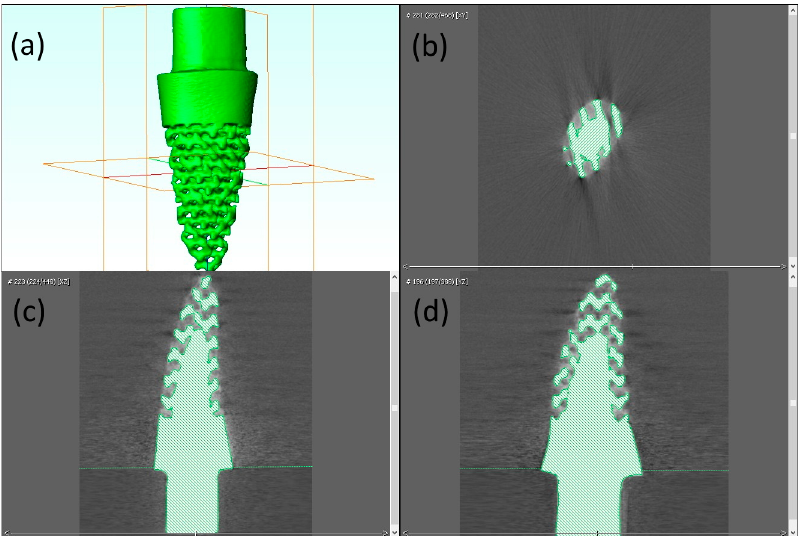
Figure 5. Radiographic image of design B implant placed in bone block: ( a ) 3D view; ( b )axial view; ( c ) coronal view; ( d ) sagittal view.